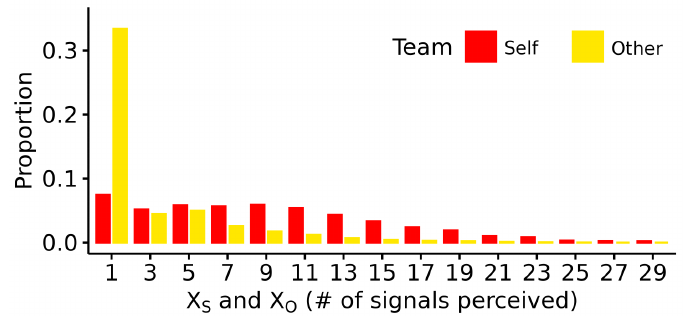
Figure 7. Average perception of a robot observing its neighbors in a segregated aggregate, which is used to encode learned information in the collective memory. The number of signals perceived by a robot from the opposite team ( X O ) is significantly lower than from its own self team ( X S ). Signals are accumulated in time windows of 10 s, a total of 60,000 observations are